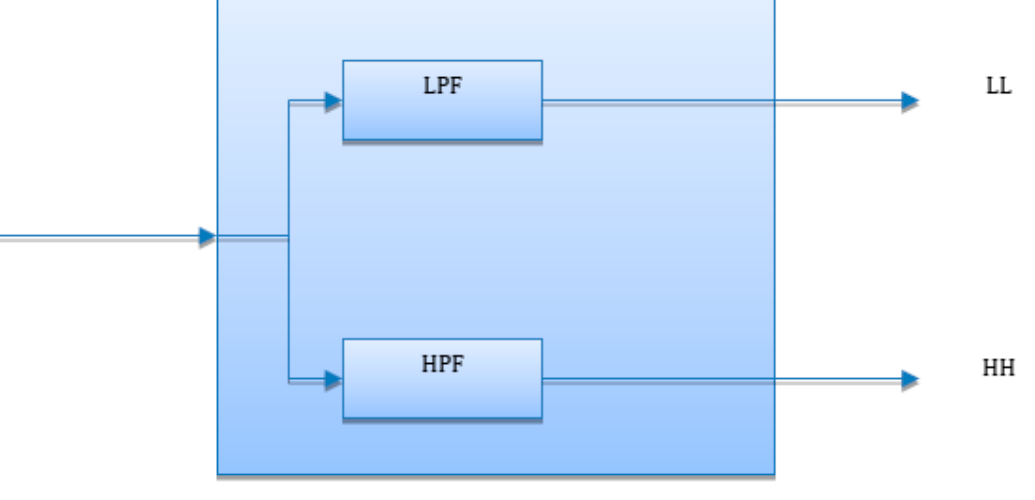
Figure 3. Approximation and Detail Coefficients.